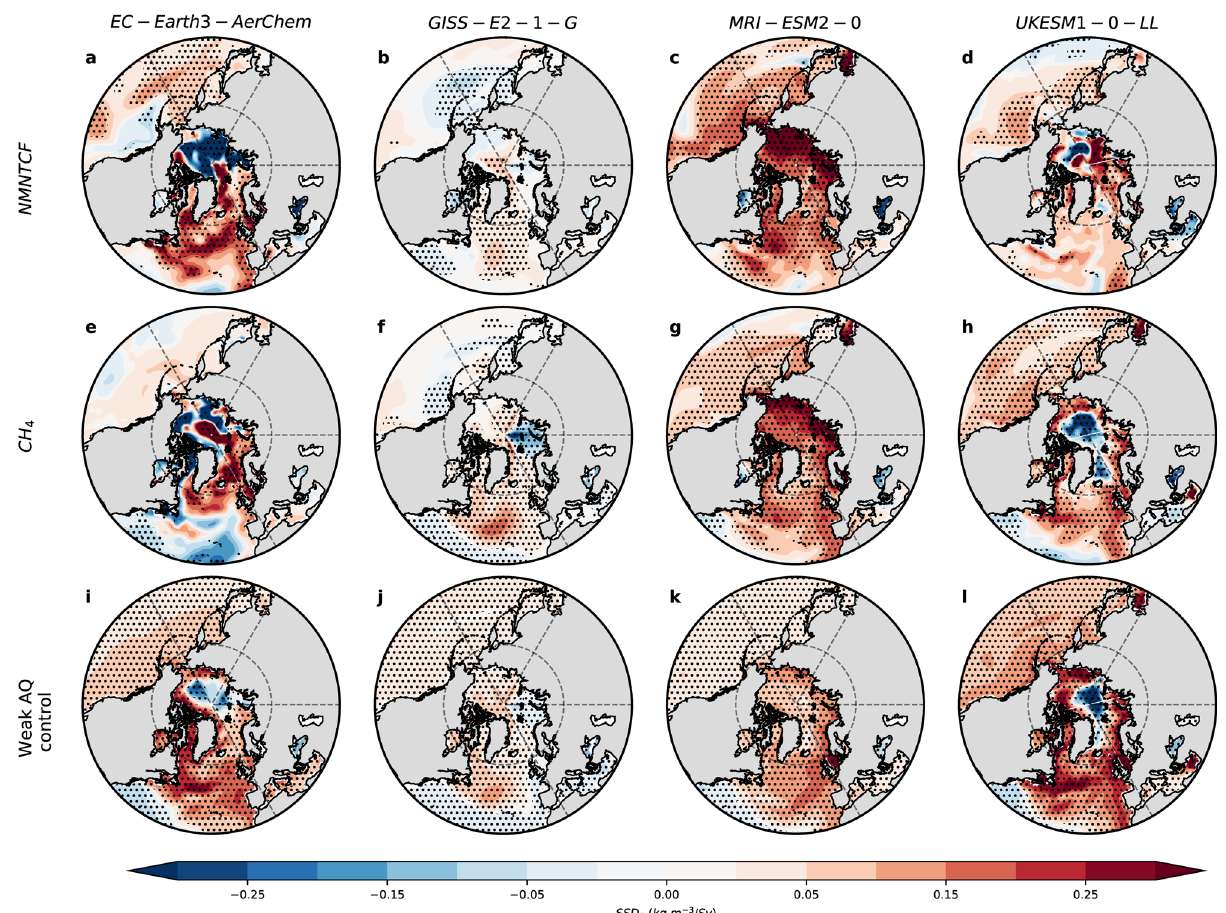
Fig. 6 2015 – 2100 annual mean haline component of sea surface density (SSD S ) regression analysis. Spatial maps of the AMOC time series regressed onto SSD S under a – d NMNTCF mitigation; e – h CH 4 mitigation; and i – l the weak air quality (AQ) control experiment for a , e , i EC-Earth3-AerChem; b , f , j GISS-E2-1-G; c , g , k MRI-ESM2-0; and d , h , l UKESM1-0-LL. Units are kg m − 3 per Sv. Symbols denote signi fi cance at the 95% con fi dence level based on a standard t